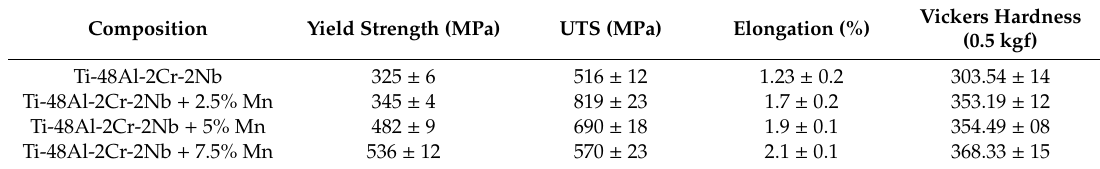
Table 3. Mechanical property analysis of the Ti-48Al-2Cr-2Nb- x Mn ( x —0, 2.5, 5, 7.5 wt%)